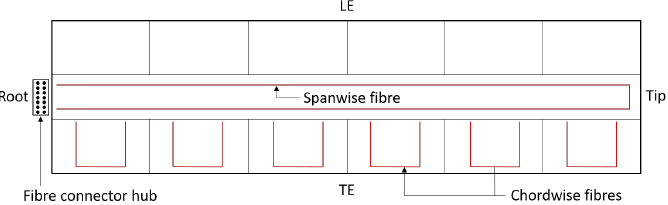
Figure 5. Layout of the spanwise and chordwise optical fibres (in red) on the SmartX wing. Connec- tions to the 14 fibres are through the fibre connector